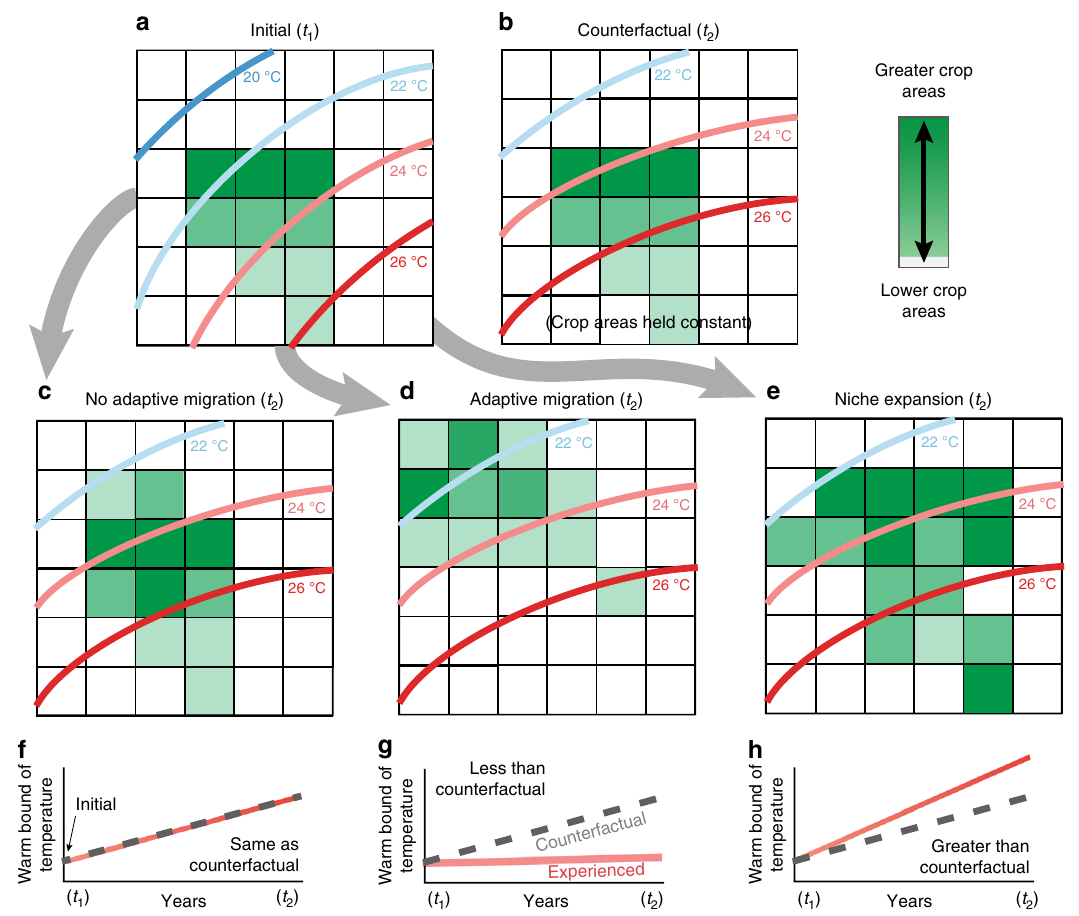
Fig. 1 Modes of agricultural adaptation. ( a – e ) represent theoretical gridded maps of crop harvested area. Dark green grid cells have the largest fraction of harvested area, decreasing as the shade gets lighter. Map ( a ) represents the initial time period ( t 1 ), while maps ( b – e ) represent theoretical scenarios at a later time ( t 2 ). As temperatures change (contours), the geographical distribution of harvested areas may or may not shift relative to a , the initial distribution. We compare observed changes in growing season temperatures of harvested areas to a counterfactual in which harvested areas remain constant ( b ). For the warm bound (95th percentile), no signi fi cant difference between the experienced temperature trend and the counterfactual temperature trend ( c , f ) would indicate no adaptive migration in response to warming; an experienced temperature trend that is signi fi cantly less than the counterfactual temperature trend suggests adaptation by crop migration to cooler areas ( d , g ); and an experienced temperature trend greater than the counterfactual temperature trend would suggest that crops are not only coping with temperature changes but expanding into even warmer areas ( e , h